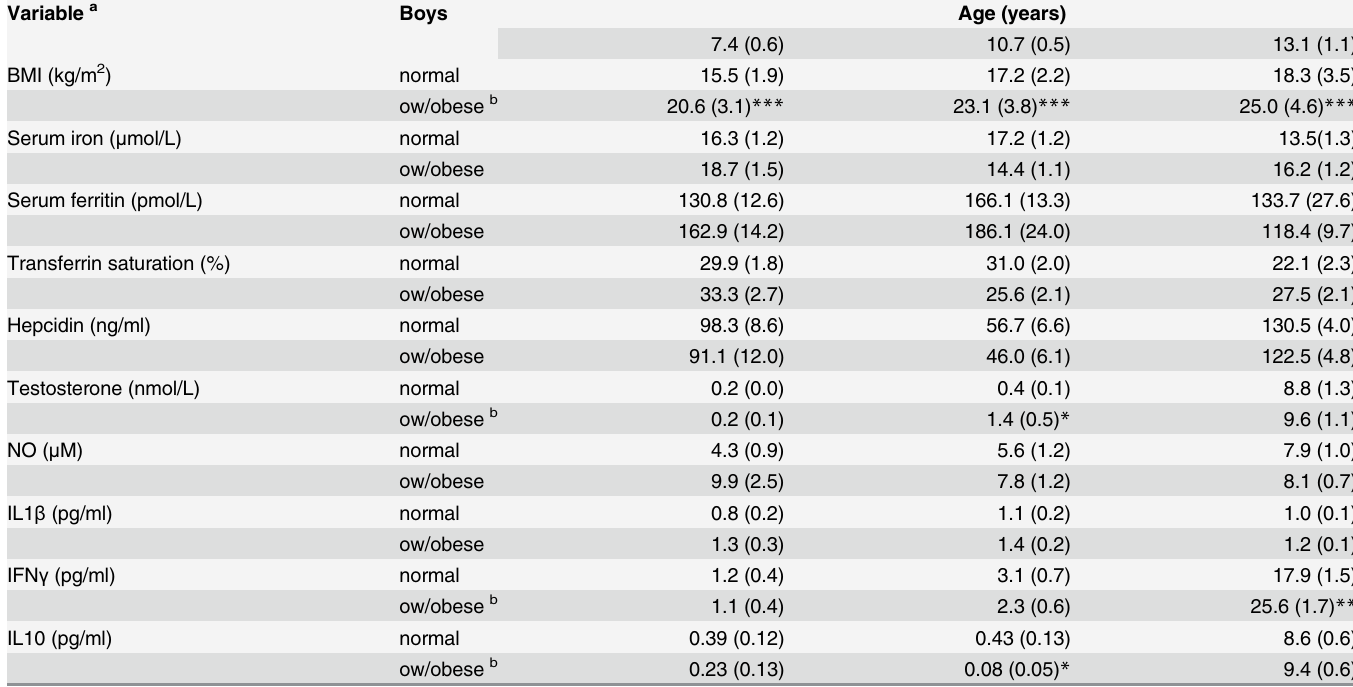
Table 3. Biochemical characteristics of study participants according to their age and nutritional